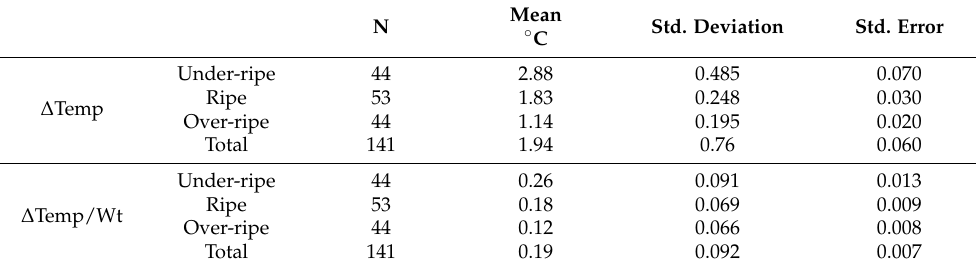
Table 3. Descriptive statistics of ∆ Temp and ∆ Temp/Wt (first experiment).